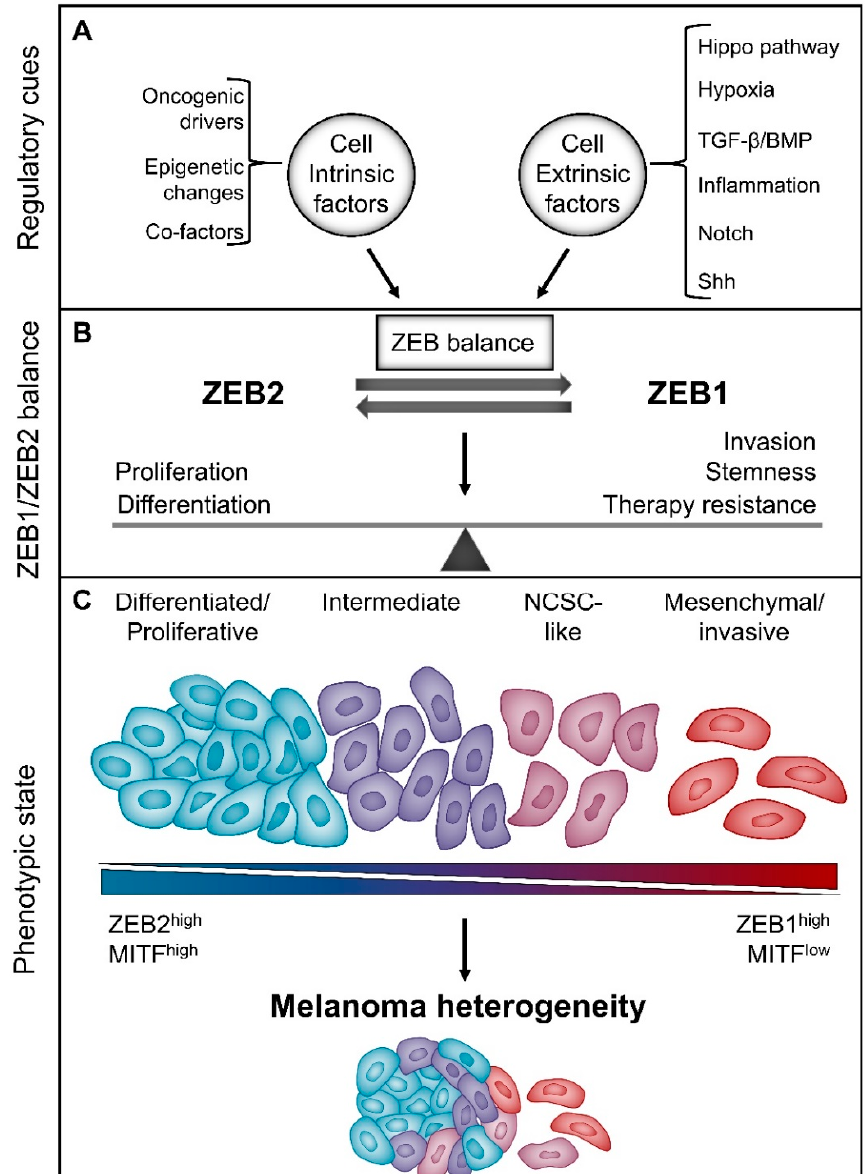
Figure 3. The intrinsic balance between ZEB1 and ZEB2 modulates melanoma phenotype switching, which drives melanoma heterogeneity. ( A ) Melanoma heterogeneity is steered by cell intrinsic factors and cell extrinsic cues that regulate the expression balance between ZEB1 and ZEB2. ( B ) ZEB2 is a regulator of di ff erentiation / proliferation while ZEB1 is associated with cancer stemness, migration / invasion and therapy resistance. ( C ) A spectrum of melanoma cell states exists dependent on the reversible balance between a ZEB2 / MITF high expression signature and a ZEB1 high expression signature. This spectrum of melanoma cell states contributes to melanoma heterogeneity.